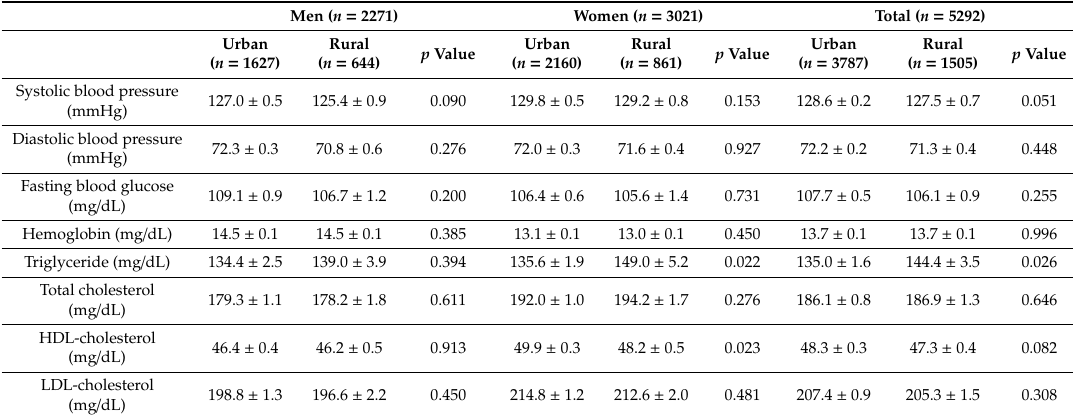
Table 2. Blood pressure and blood profiles of rural and urban Korean elderly.